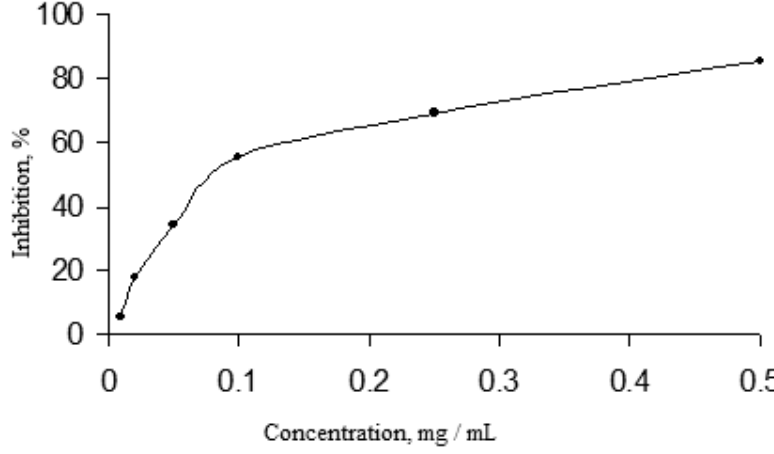
Figure 1. H O scavenging activity of C. rotundus rhizomes ethanol extract at different 2 2 concentrations. Each value represents means ± SD (n=3).